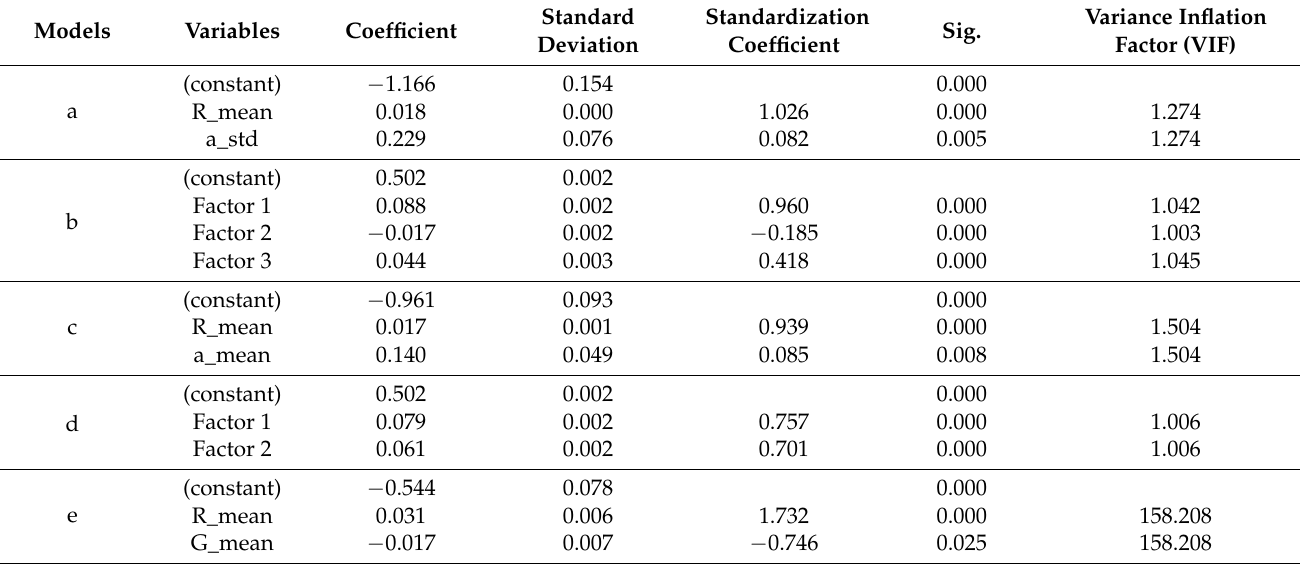
Table 3. Results of multiple linear regression (MLR) prediction models for chlorophyll content of Astragalus